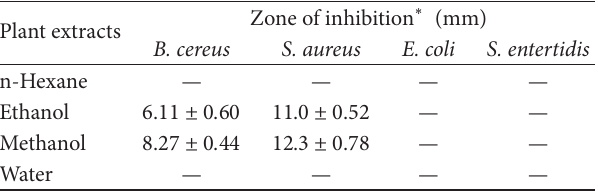
Table 2: Antibacterial activity of Psidium guajava leaves of the screened solvents